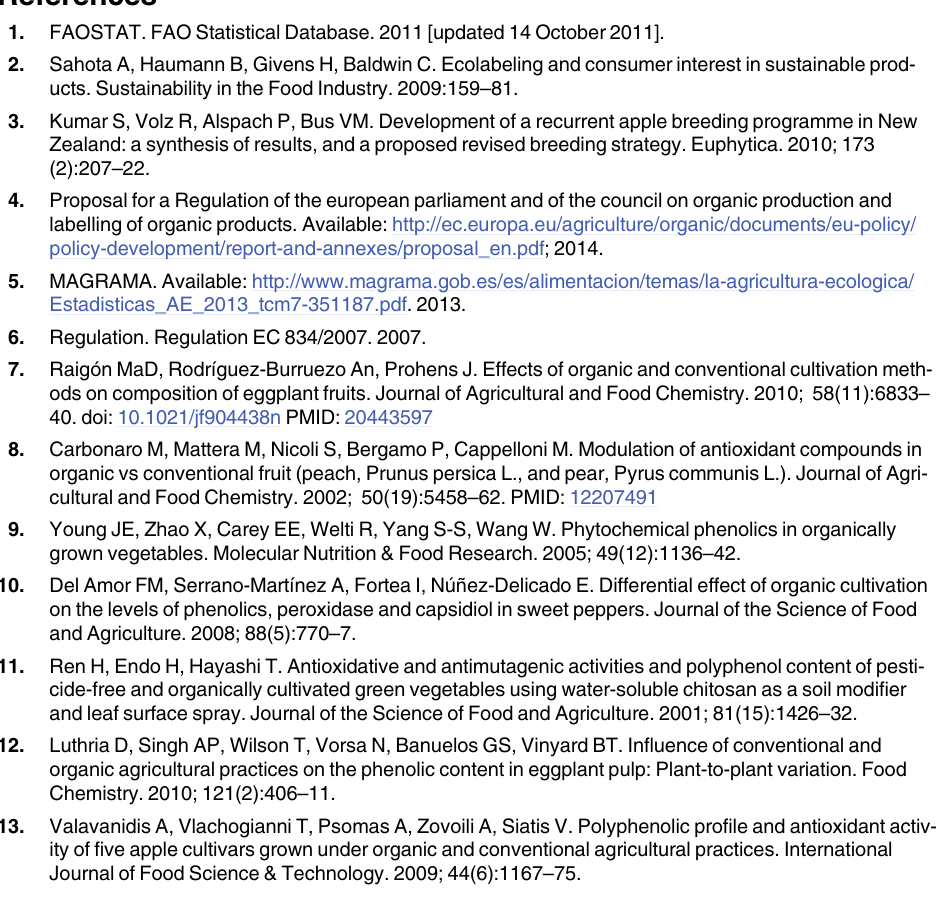
S1 Table. ANOVA interactions between cultivation system, genotype and year factors, and effects on total anthocyanins, polyphenols, antioxidant capacity and carotenoids values. Means with different letters in the same column show significant differences. P < 0.05. TAC = Total anthocyanins content. TPC = Total polyphenols content. ABTS-h = ABTS hydrophilic extract. TCC = Total carotenoids content. ABTS-l = ABTS lipophilic extract. CS: Cultivation